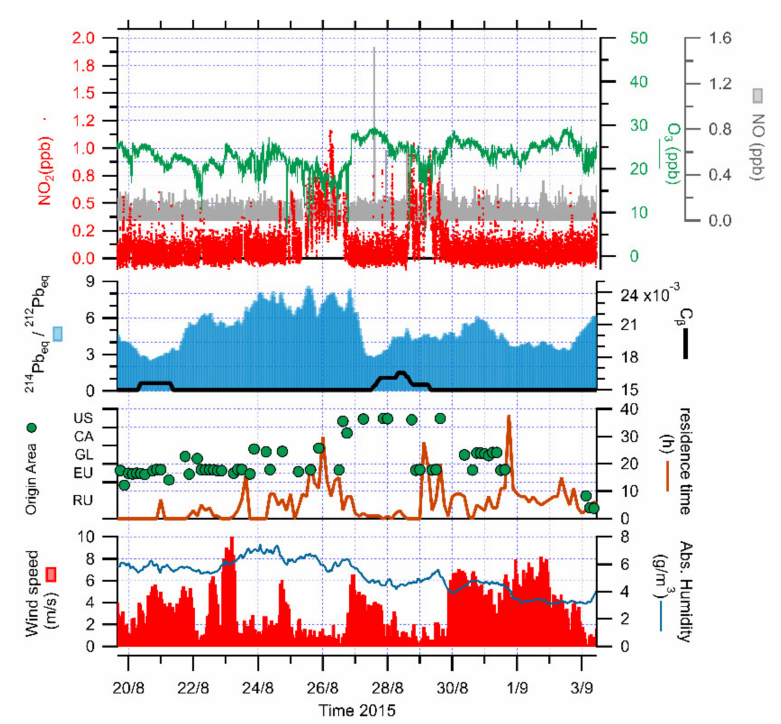
Figure 7. Time series of NO, NO 2 and O 3 concentrations, together with isotopic composition of radon progeny (short-lived progeny/long-lived progeny ratio, 214 Pb eq / 212 Pb eq , and very-long-lived component, C β ), origin (US—NW United States; CA—Canada; GL—Greenland; EU—NW Europe; RU—Russian Federation) and residence time of air masses, wind speed and absolute humidity during a sequence of stability conditions in August 2015 at